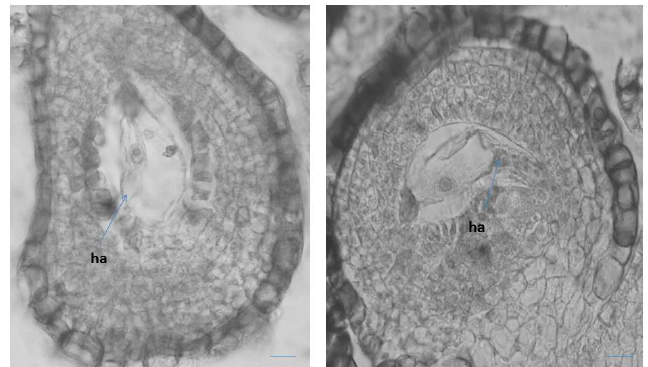
Figure 5. Central cell in the ES with outgrowth like haustorization (ha) to the chalaza of the ovule. Scale bar = 20 μ m.